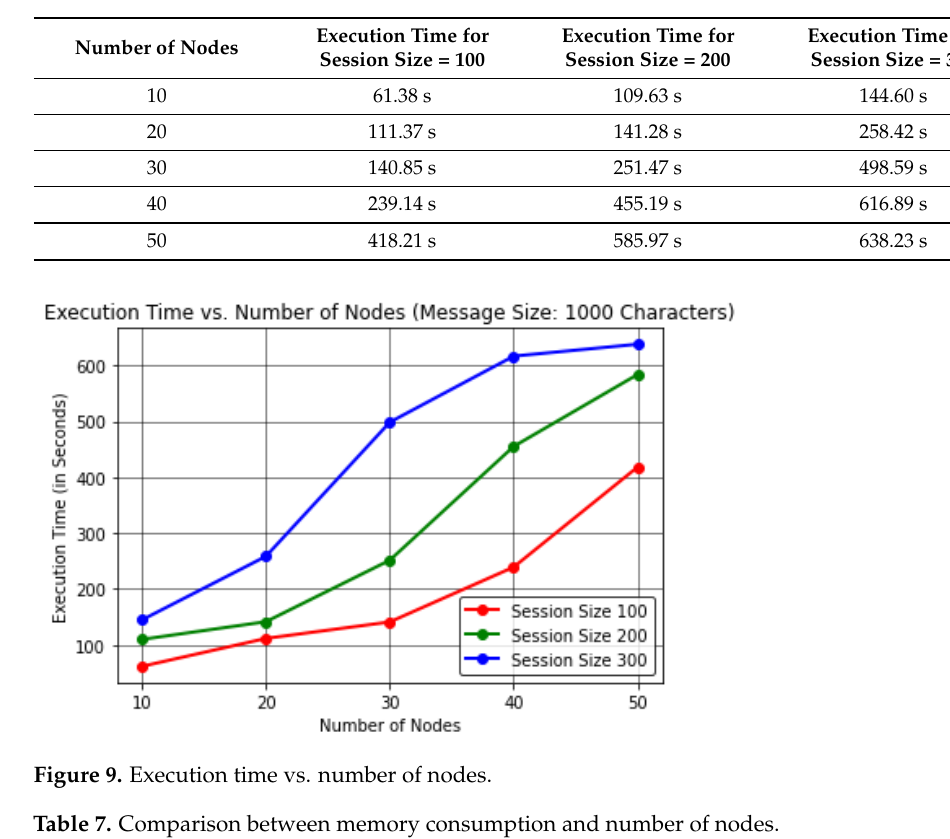
Table 6. Comparison between execution time and number of nodes.